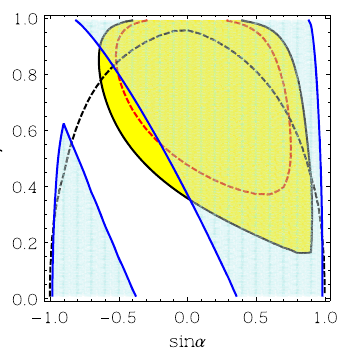
Fig. 8 The extent of parameter space admissible (regions in yellow) after demanding that the rates for the gg → γγ (left), and the gg → h → WW ∗ / Z Z ∗ (right) match the experimentally reported values for the 125 GeV higgs for the case of the heavy higgs H being SM-like. Also overlaid in each plot are the corresponding regions in the Type I 2HDM (regions enclosed by the blue contours). The dashed red contours are the ATLAS h → b ¯ b limits